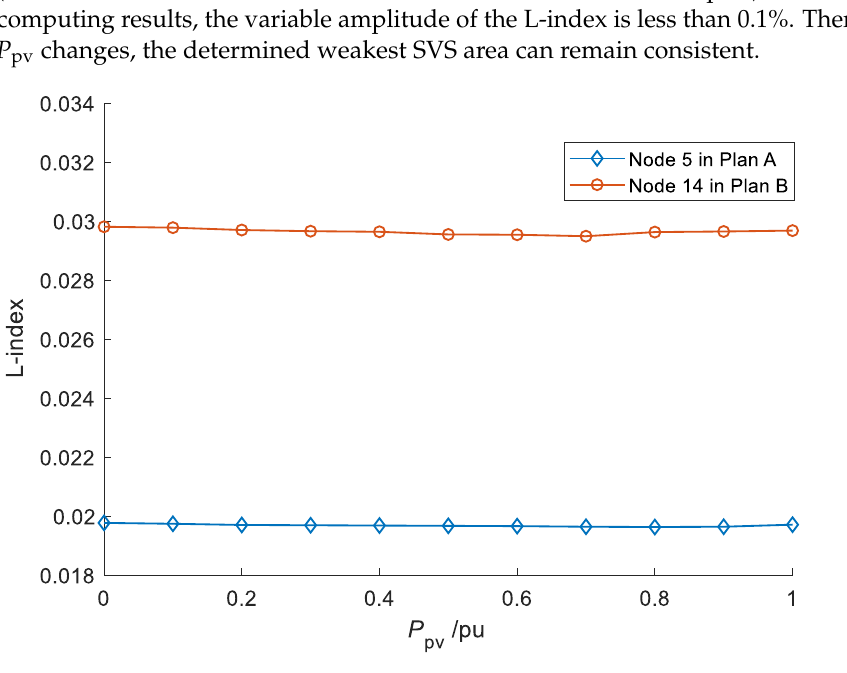
Figure 5. PV active output P pv —L-index curves (Load multiple lm = 1 pu).